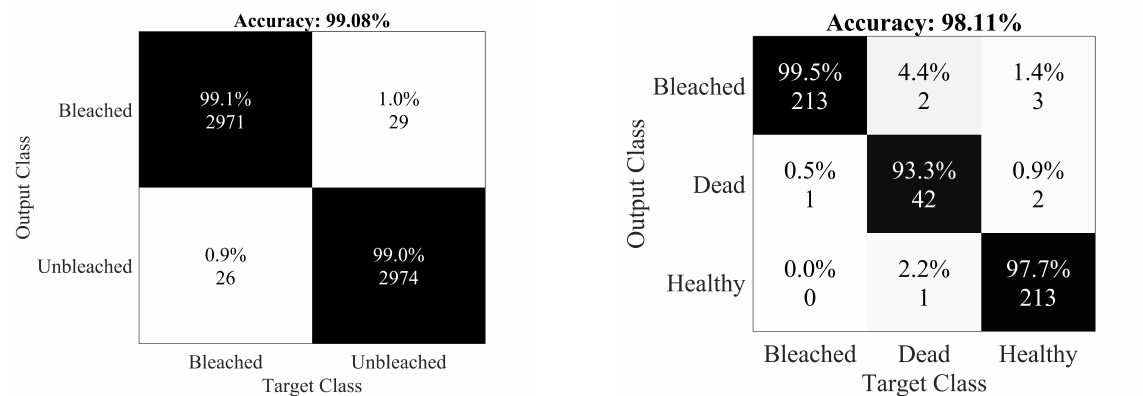
Figure 11. Confusion matrices of binary class and multi-class datasets.